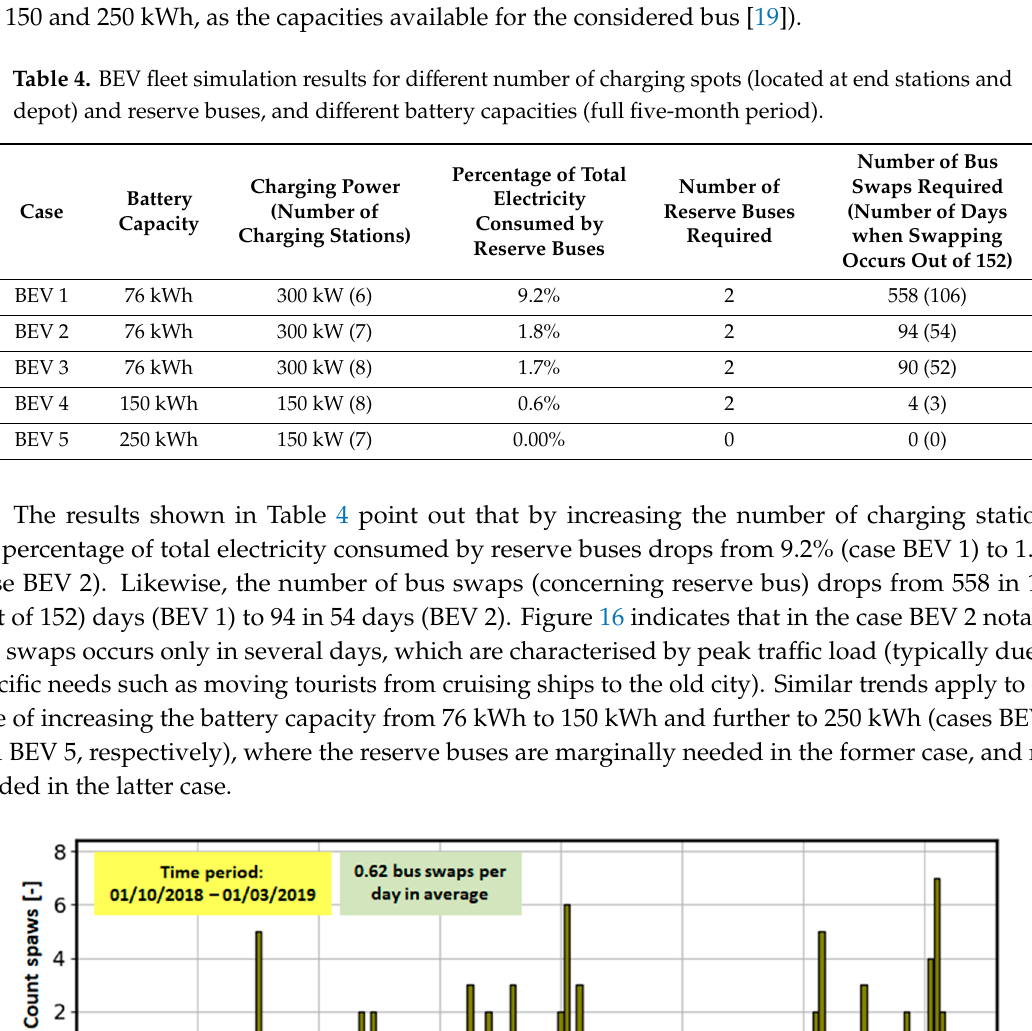
Table 5. Fuel and electricity consumption per fleet type for full five-month period.